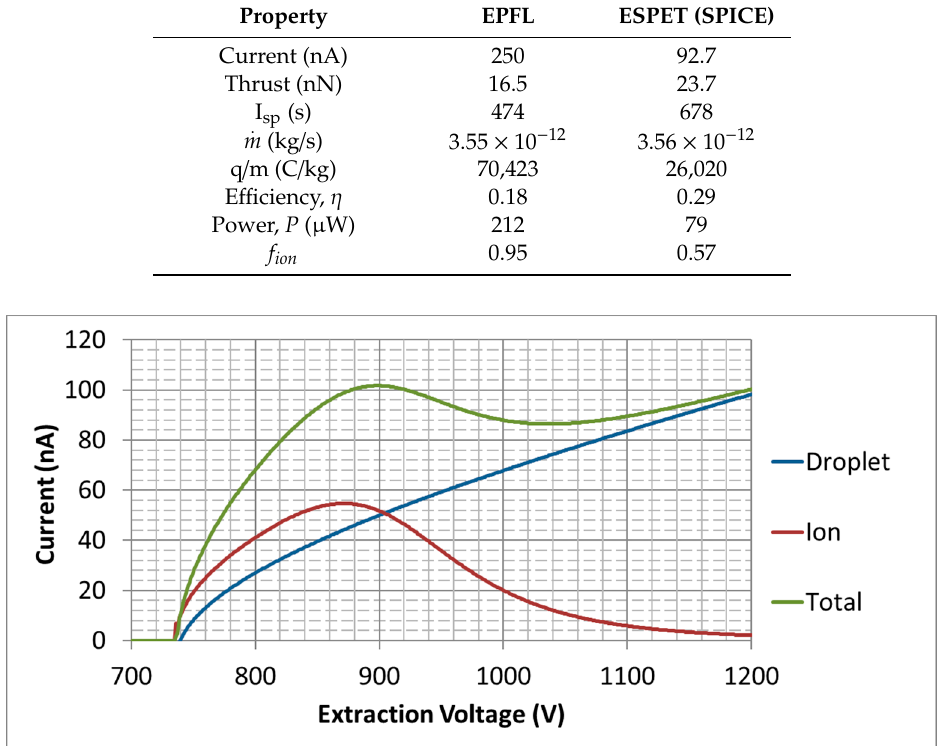
Figure 14. Total VI curve comparison between experiment (EPFL) and ESPET QuickSolver. The statistics associated with the shading in Figure 14 is entirely attributable to the variance of the emitter capillary radius given by the tolerance quoted by Dandavino et al. [1] (Table 8). The critical benchmarking parameters are the C R mode switching limit, p scale , and B , the pure ionic model voltage– current slope parameter. These parameters were adjusted to optimize the comparison in Table 7. The optimized pure ionic mode slope parameter B is set to 1.8 × 10 − 8 Ω − 1 , which is a factor of 3 greater than that derived from the data in Figure 6. p scale is higher than what we found using the SPICE model. The QuickSolver model predicts that 46% of emitters are in pure ionic mode. The remaining emitters are in mixed cone ‐ jet mode.